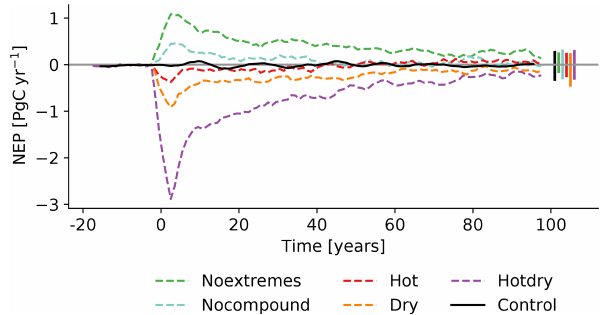
Figure 8. Time series of global annual NEP from the simulations that use the shared spin-up (black line). Scenarios are shown in dashed coloured lines. The first 20 years ( − 20 to 0) represents the last 20 years of the shared spin-up. The variability (mini- mum to maximum) in global NEP in the individual-spin-up simu- lation (spin-up uses data from the respective scenarios) is indicated by the bars on the right hand side. A 5-year moving average was applied to smooth the time